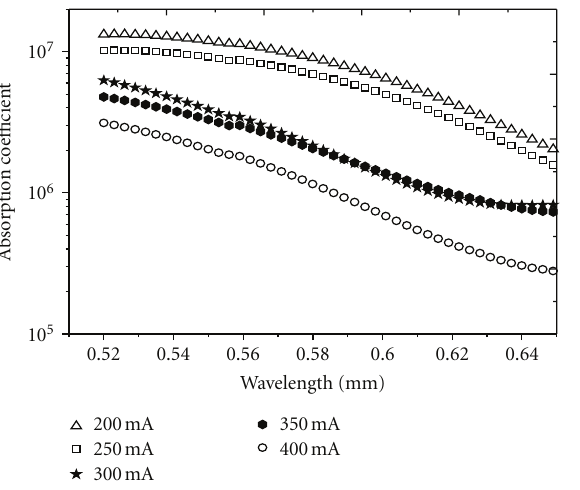
Figure 6: Optical absorption spectra of PASL samples. Table 1: Evolution of the bandgap energies.